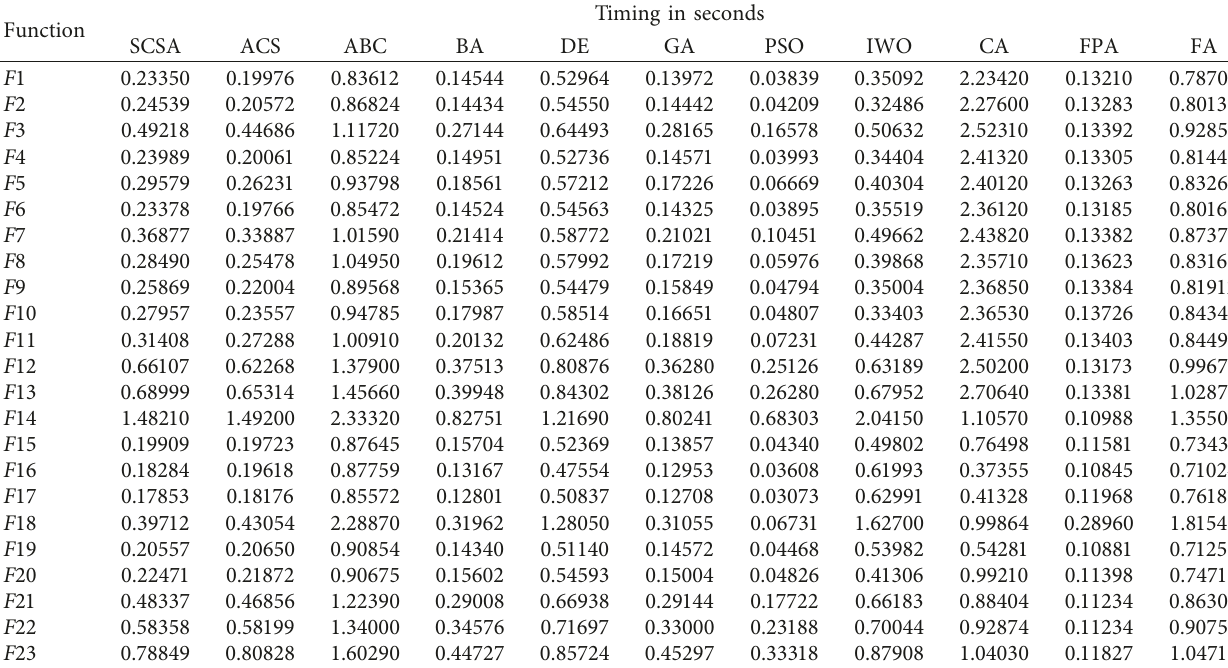
Table 7: Comparison of ACSA against the 10 other optimization algorithms on runtime in